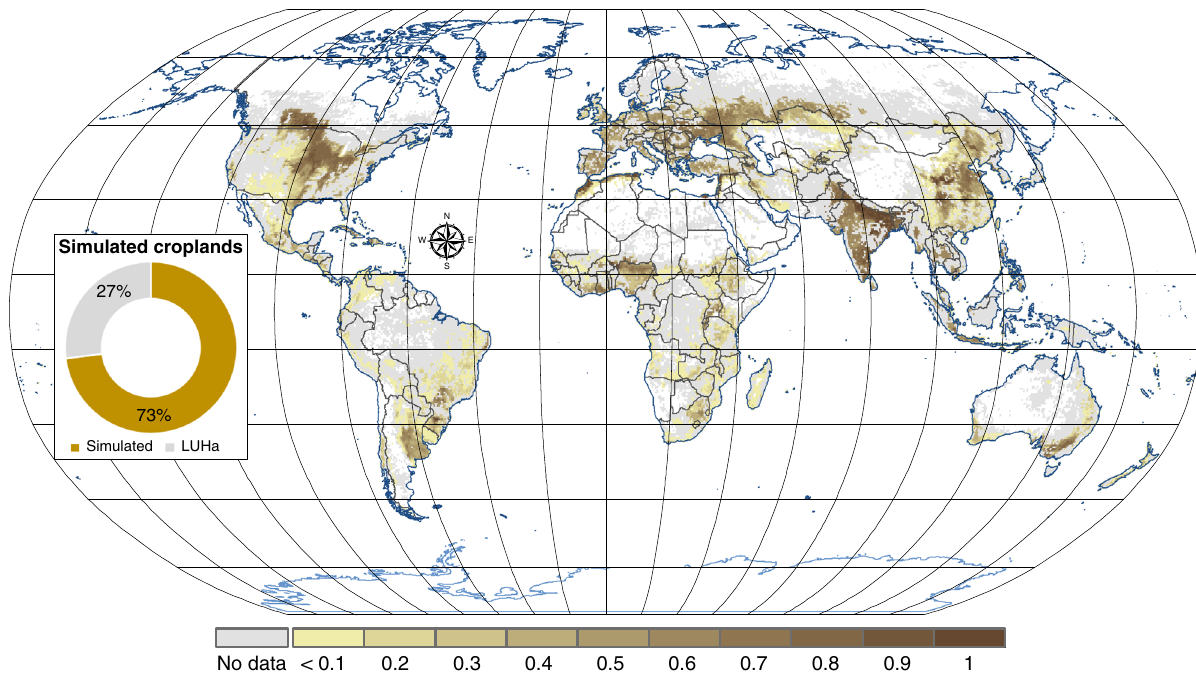
Fig. 1 Modeled area and global distribution of cropland. The chromatic scale represents the cropland ratio fraction of cropland from total land per pixel of the modeled land. The gray color indicates the cropland areas that were excluded from the modeling due to data unavailability. The insert panel illustrates the simulated versus total cropland area according to the harmonization of land-use LUHa.v1 database 73